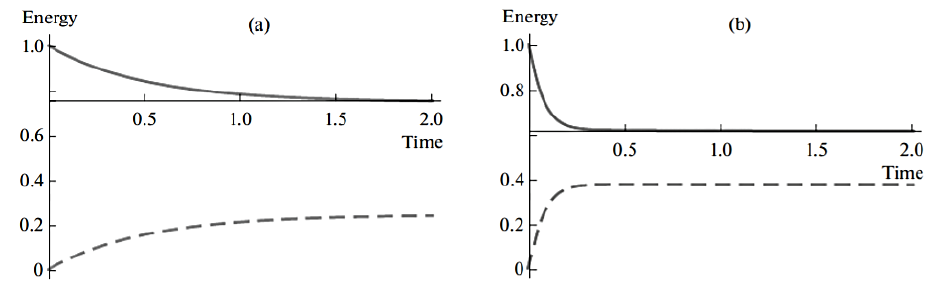
Figure 1. Dimensionless kinetic energy k = k / k x , k x = ( V 0 z ) 2 L 2 / C (the solid line) and potential energy = / x , x = ( V 0 z ) 2 L 2 / C (the dashed line) of turbulence as functions of dimensionless time t = t / t x , t x = 1/ V 0 z C at different values of the Richardson number ( a ) 0.5 and ( b ) 5. The initial conditions and the anisotropy parameter R = 0.5 are the same in both cases.